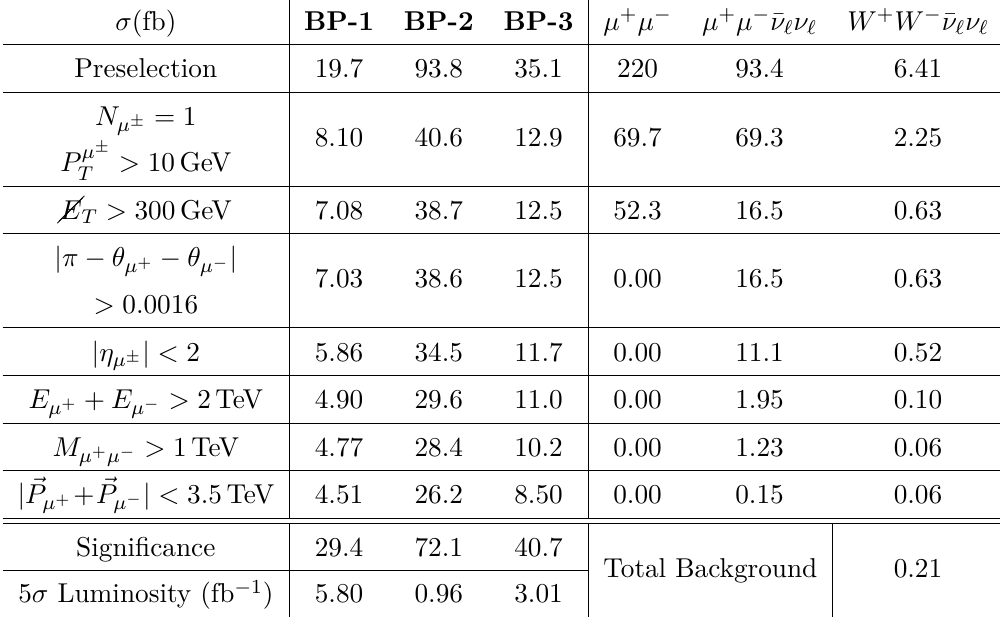
Table 2 . Cut flow table for the dimuon signature µ + µ − + (cid:0) E T from BP-1, BP-2, BP-3, and various √ background processes at the s = 14 TeV MuC. The significance S/ assuming an integrated luminosity L = 200 fb − 1